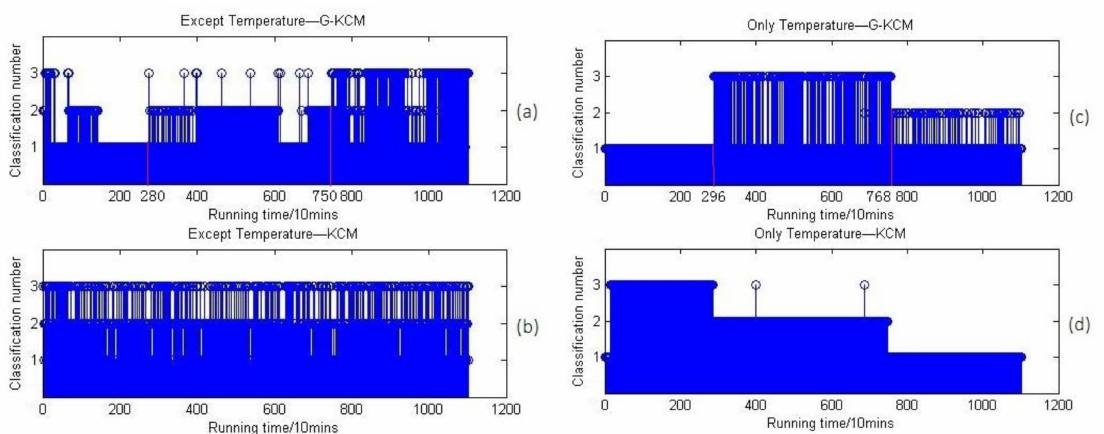
Figure 19. ( a ) Oil parameters except temperature clustering results based on G-KCM; ( b ) oil parameters except temperature clustering results based on KCM; ( c ) only temperature clustering results based on G-KCM; ( d ) only temperature clustering results based on KCM.